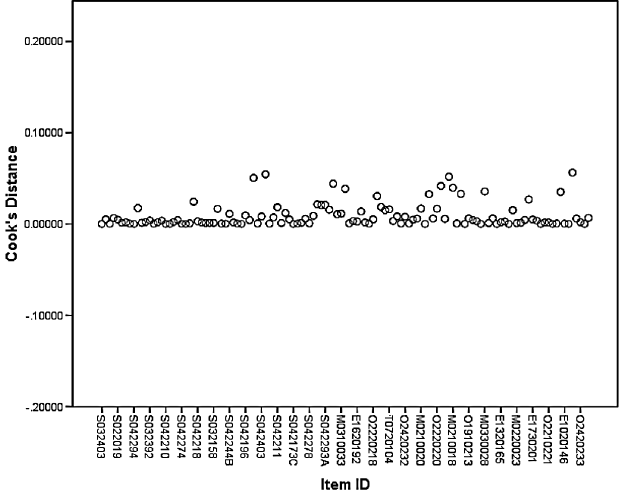
FIG. 2. Cook’s distances for used items.